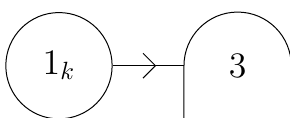
Figure 7 . The quiver for the SU(3)[1,2] theory with a CS term with coupling k on the U(1) node.